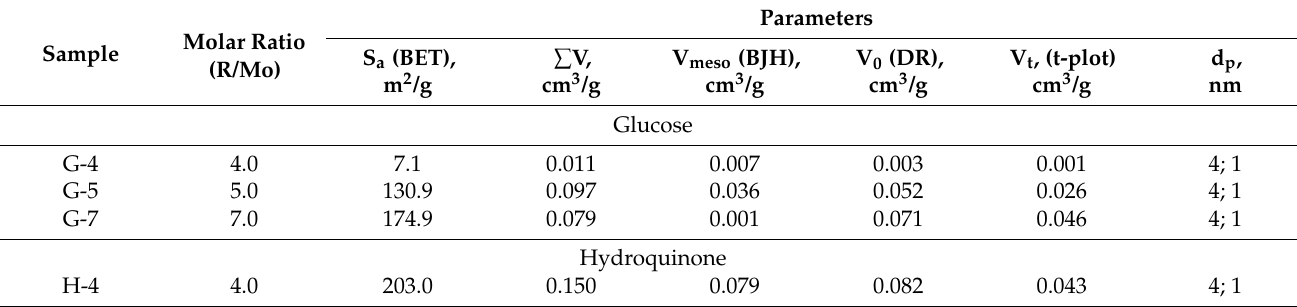
Table 1. Characteristics of the porous structure of Mo 2 C synthesized from molybdenum blue xerogels using glucose and hydroquinone with different R/Mo molar ratios, calcined at 900 ◦ C in an inert atmosphere.